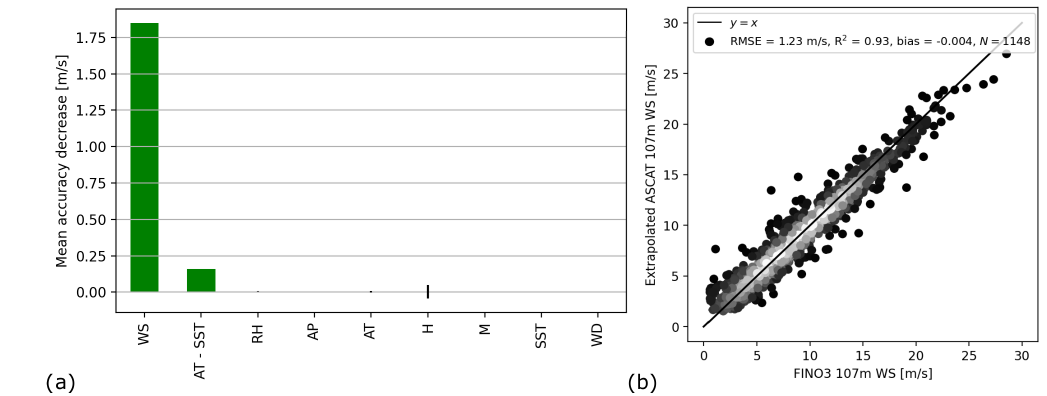
Figure 2. (a) Mean accuracy decrease in the mean square error contribution from the training variables. The small vertical black bars represent the standard deviation of the mean training dataset. (b) Scatterplot of the predicted ASCAT 107m wind speed ( y axis) versus FINO3 107m wind speed ( x axis) measurements, based on the 20% validation dataset not used in the model-training process.